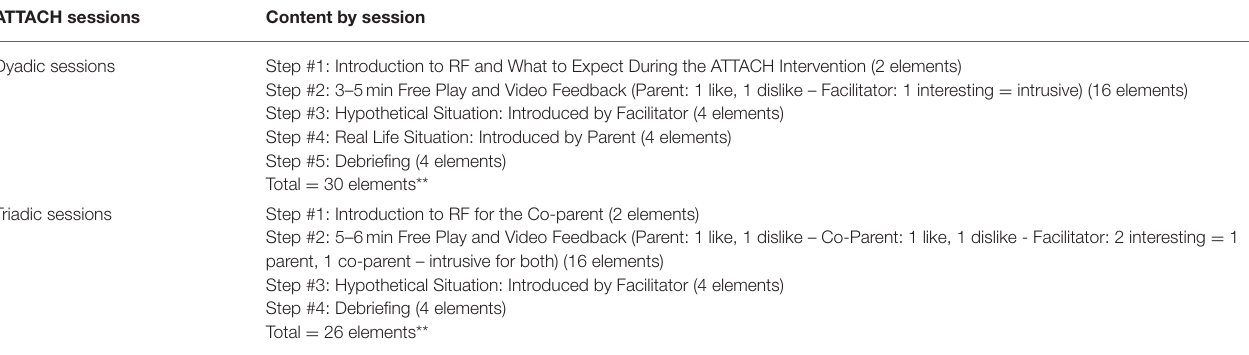
TABLE 2 | ATTACH TM program content outline for dyadic and triadic sessions. ATTACH